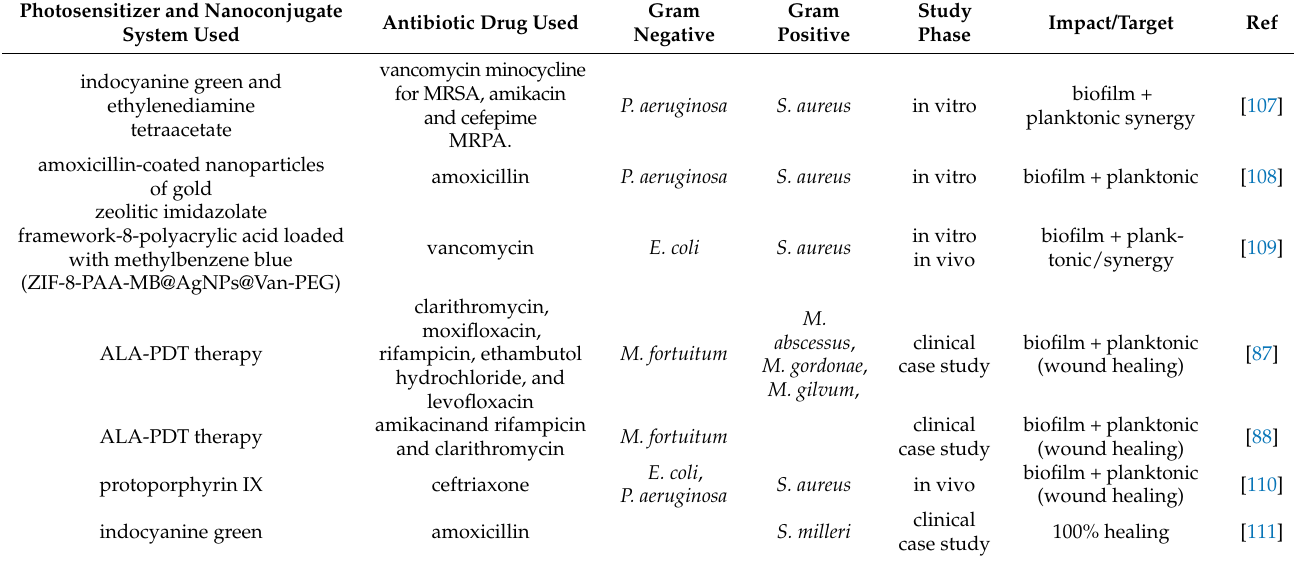
Table 2. Antibacterial photodynamic therapy in combination with antibiotic